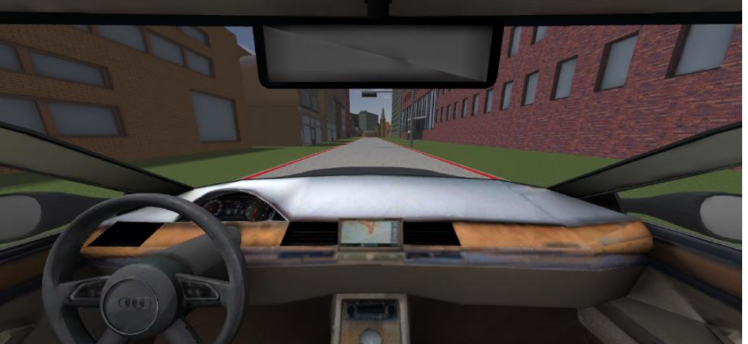
Figure 3. The driver’s viewing point.